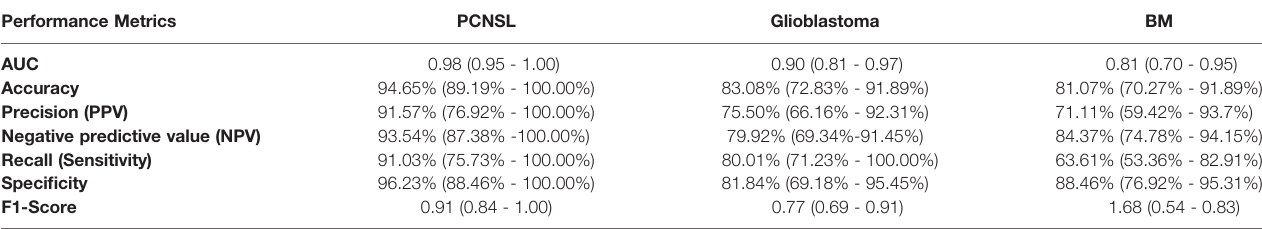
TABLE 1 | Convolutional neural networks model ’ s performance metrics in differentiating PCNSL, Glioblastoma, and BM. Performance